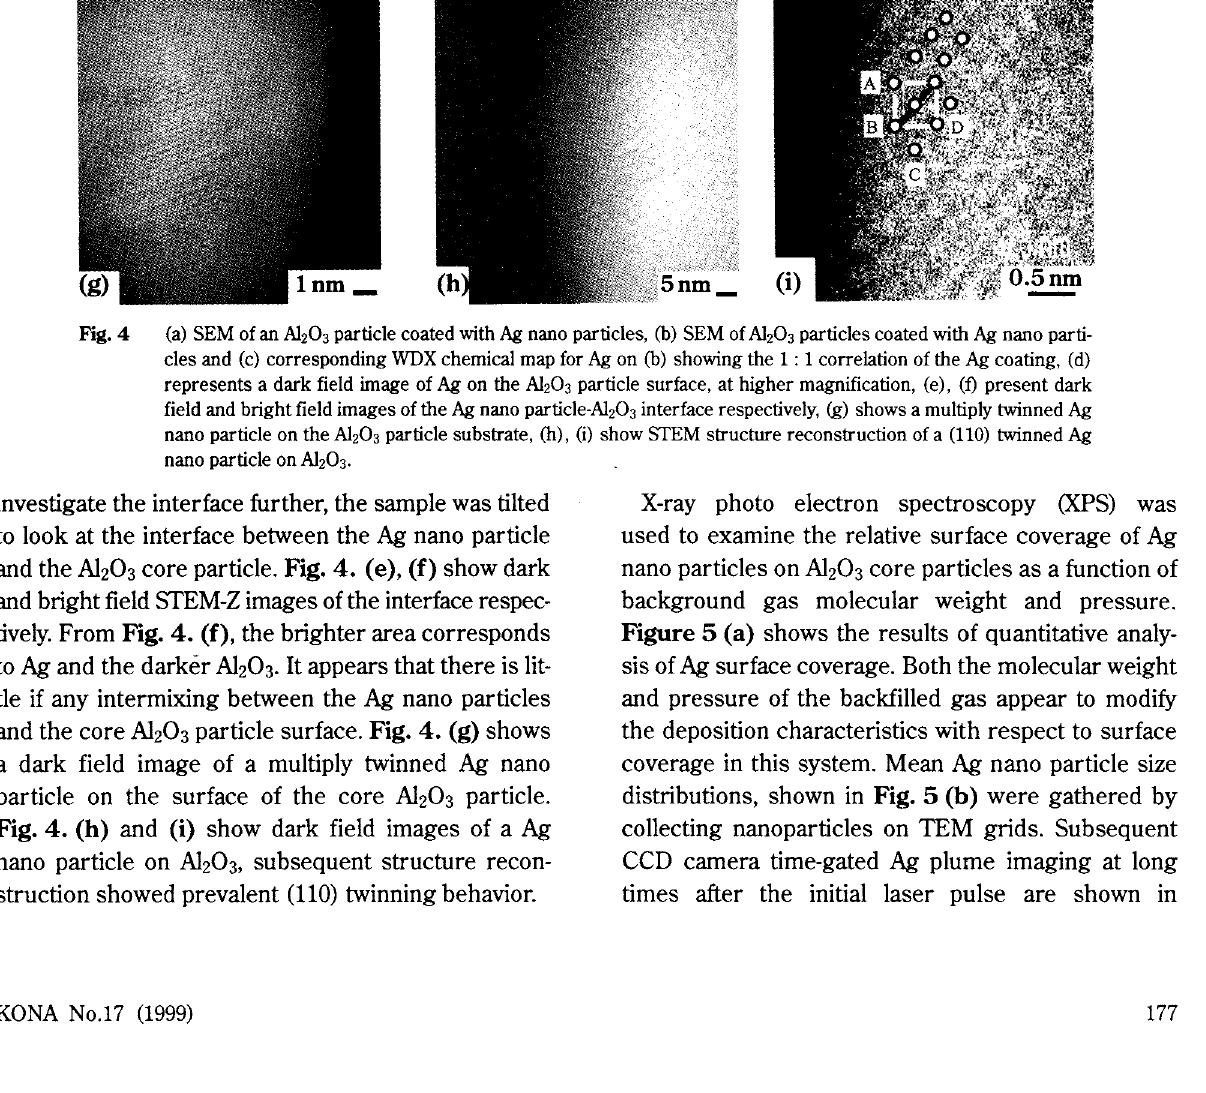
Fig. 4. (h) and (i) show dark field images of a Ag nano particle on Al 2 0 3, subsequent structure recon struction showed prevalent (110) twinning